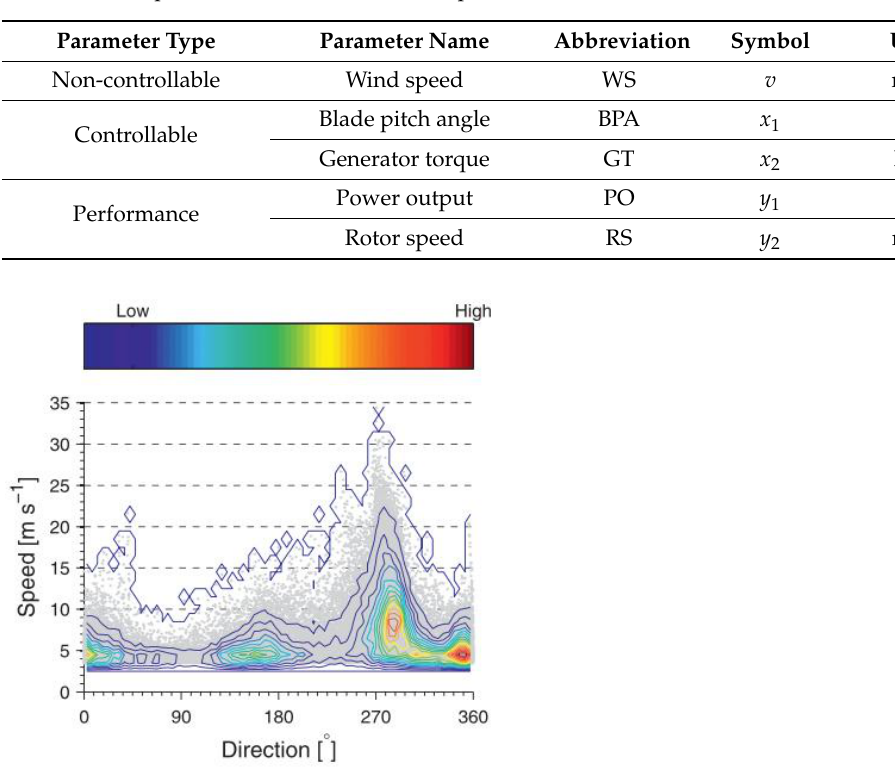
Table 3. List of parameters selected for wind speed estimation [17].